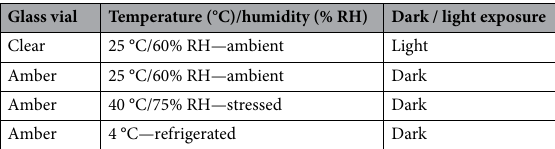
Table 2. Storage conditions of e-liquid formulations.